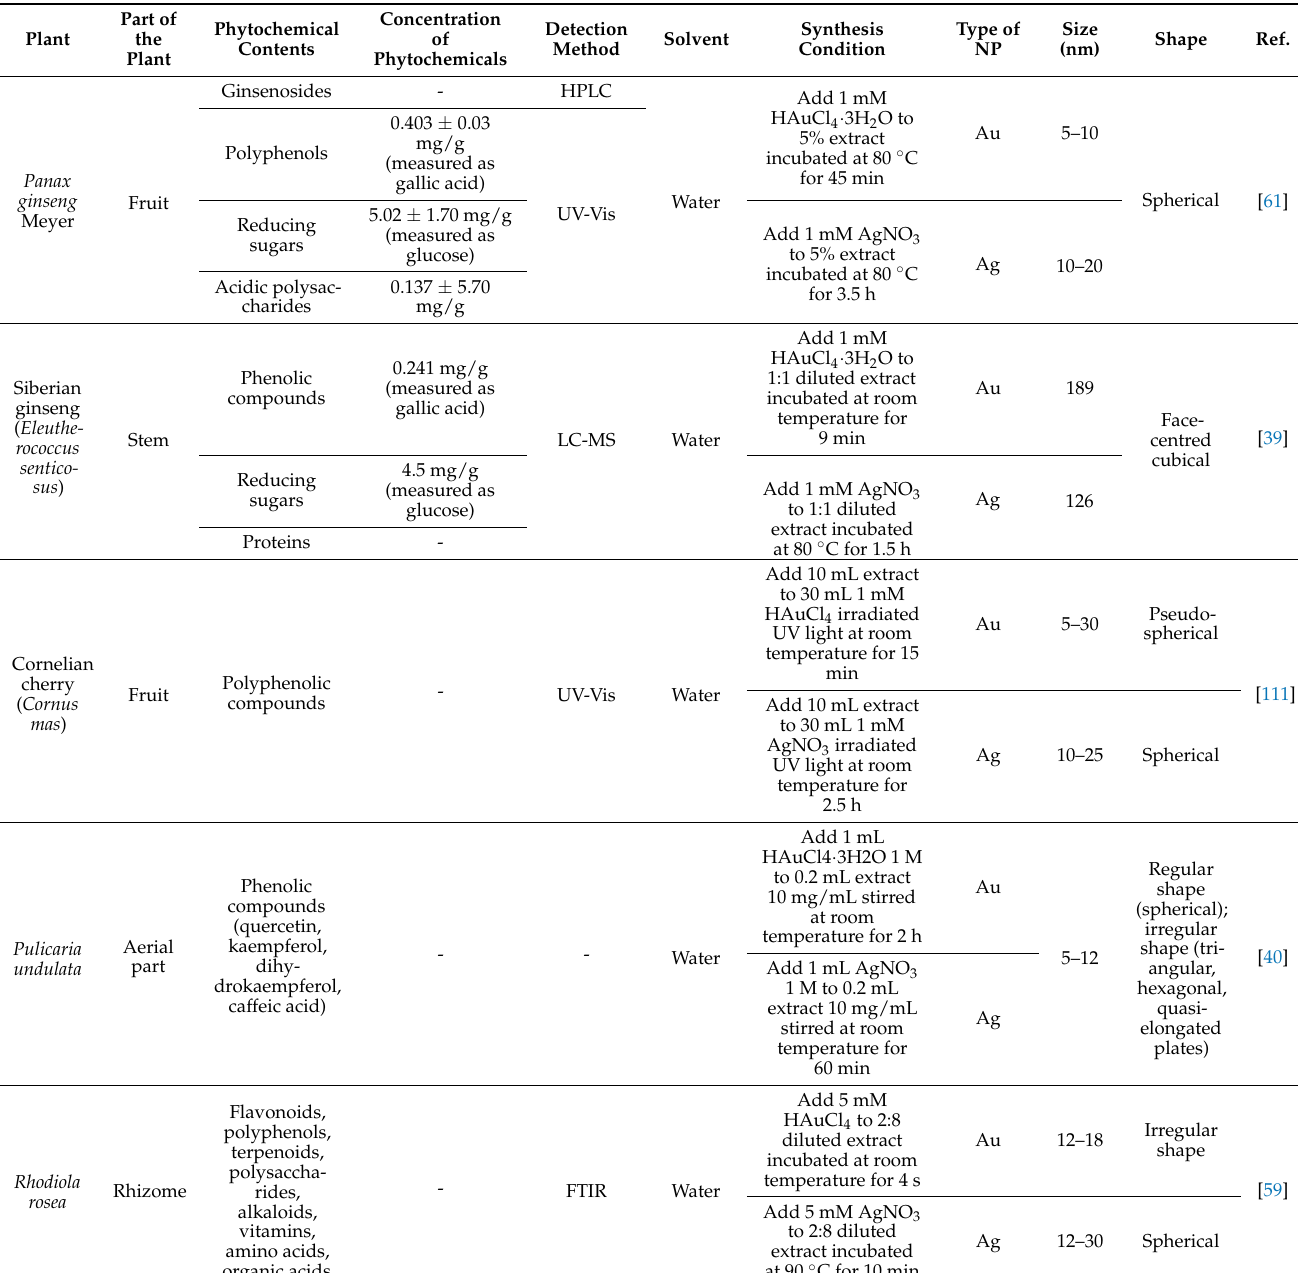
Table 8. Plant-based gold and silver nanoparticles and their